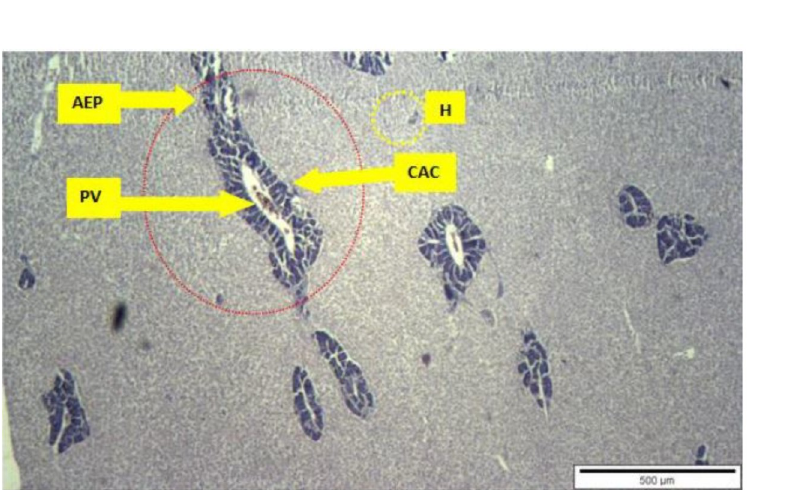
Fig 4. Liver stained with haematoxylin and eosin, bar 500 μ m, whereby all the concentrations of non-target organisms test showed undamaged hepatic architecture hepatocytes (H), acini exocrine pancreas (AEP) with centro acinar cells (CAC) and portal vein (PV).